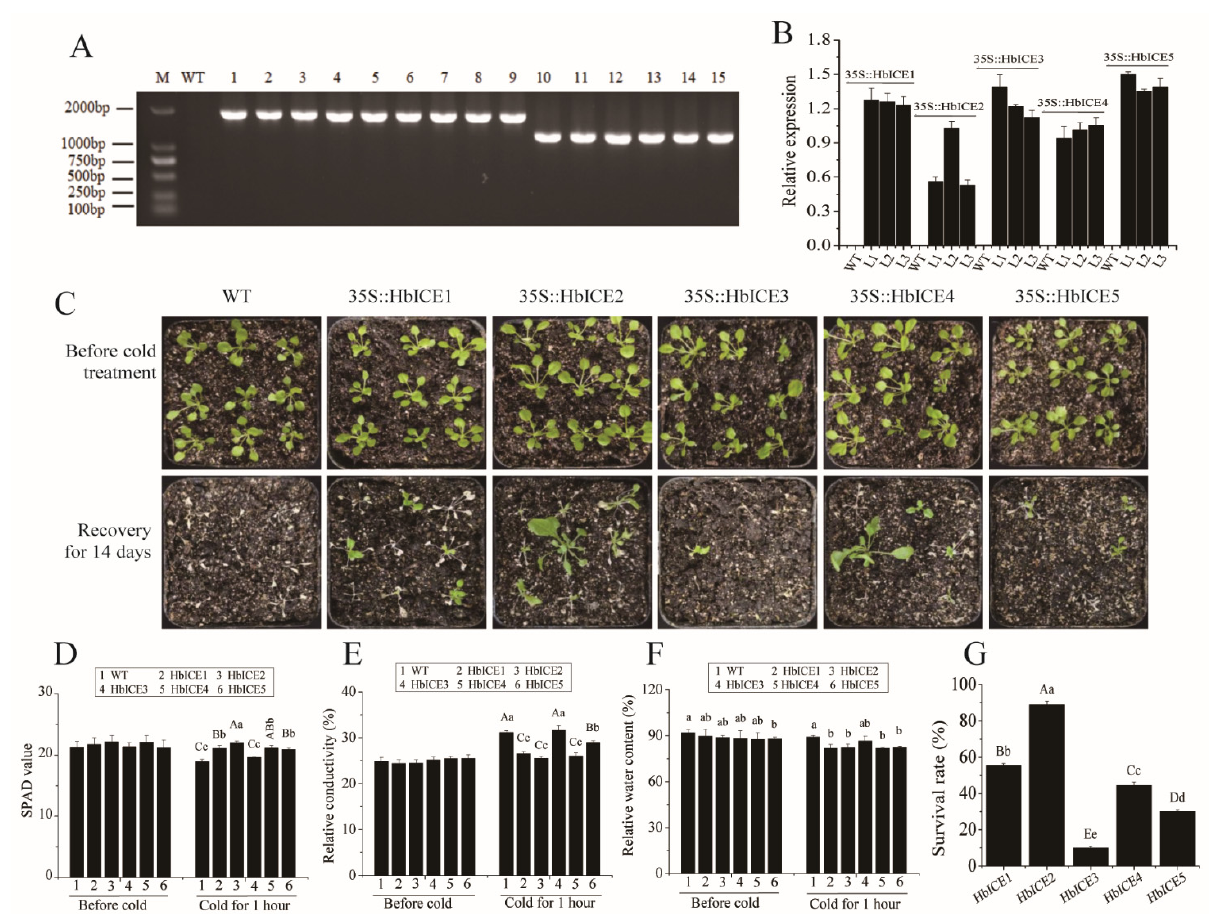
Figure 4. Overexpression of HbICEs conferred enhanced cold tolerance in Arabidopsis . Identification of transgenic Arabidopsis lines overexpressing HbICEs by Genomic RT-PCR ( A ) and qPCR ( B ). M, marker; WT, wild-type; 1–3, transgenic lines overexpressing HbICE1 ; 4–6, transgenic lines overexpressing HbICE2 ; 7–9, transgenic lines overexpressing HbICE3 ; 10–12, transgenic lines overexpressing HbICE4 ; 13–15, transgenic lines overexpressing HbICE5 . The phenotypes of WT and transgenic plants before and after cold treatment ( C ). SPAD value ( D ), relative conductivity ( E ), relative water content ( F ), and survival rate ( G ) in Arabidopsis WT and transgenic plants analyzed before and after cold treatment. The capital letters and lowercase letters respectively represent very significant difference ( p < 0.01) and significant difference ( p < 0.05). The same